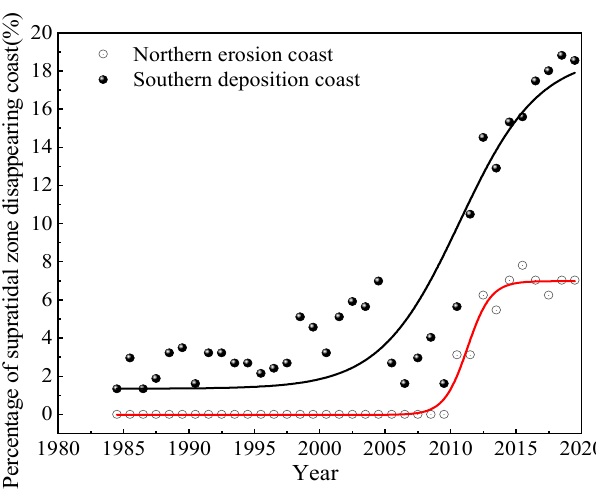
Figure 14. Percentage of coast without supratidal zone around the Abandoned Yellow River Delta.